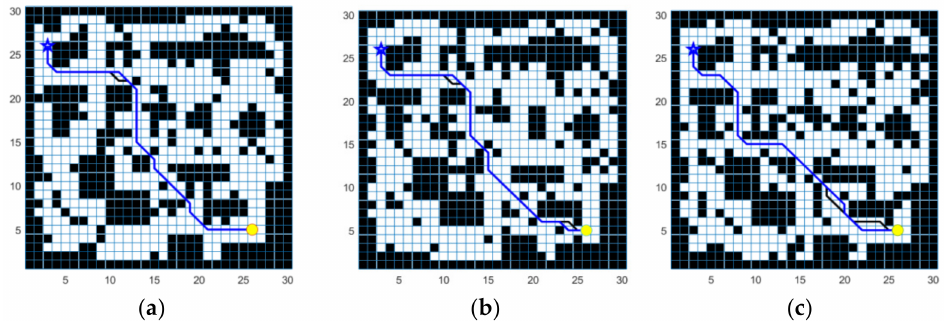
Figure 7. Algorithm robustness verification: ( a ) Randomly generate 120 obstacles; ( b ) randomly generate 150 obstacles; ( c ) randomly generate 180